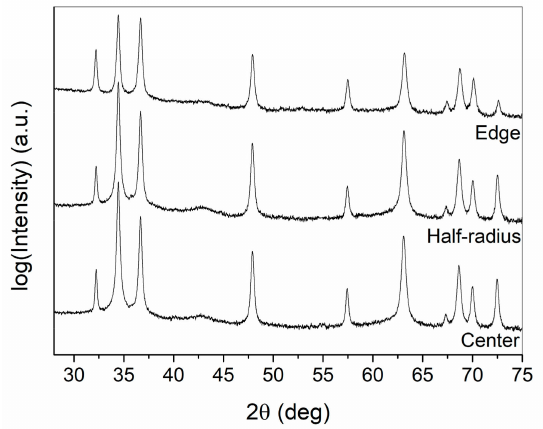
Figure 5. High resolution XRD patterns of the MgTN_3h_N3 sample taken at the center, half radius and edge of the